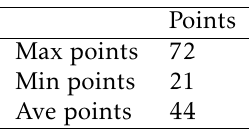
Table 6. Statistics on point per game in rally point system Volleyball with 25 points (n=486).